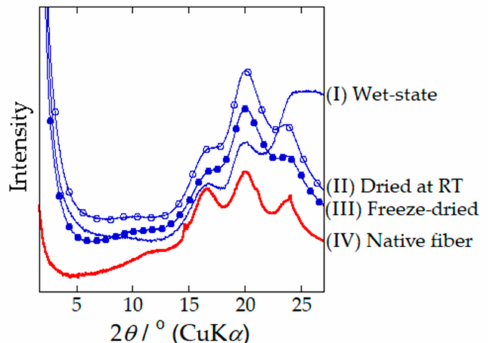
Figure 1. Wide-angle X-ray di ff raction (WAXD) 2 θ -profiles of S. c. ricini silk gland fibroin gel (SGF-gel) in the wet- and dry-states. Profile I is for the wet-state gel (in 40%-EtOH), II is for the gel dried at room temperature, III is for the freeze-dried gel, and IV is for native